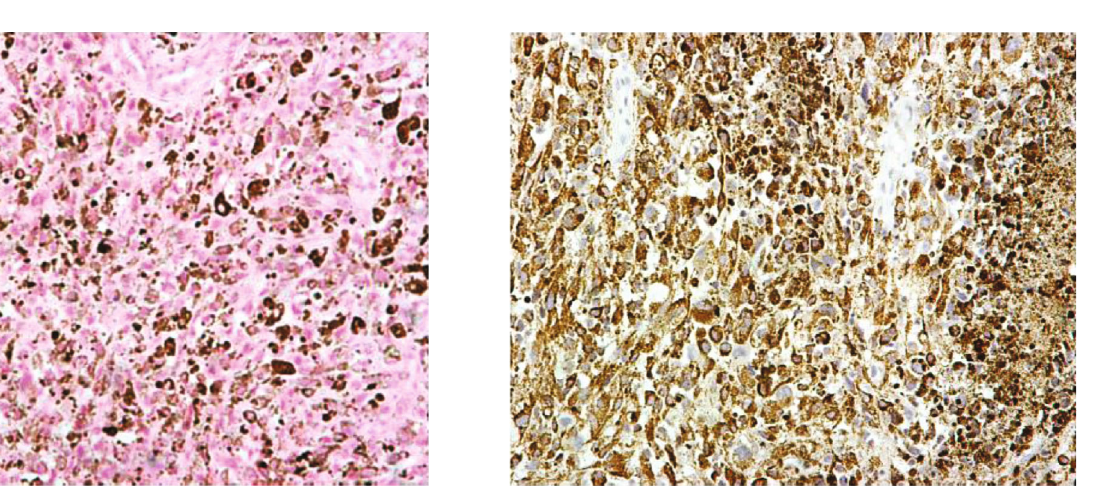
Figure 1: A fully pigmented growth was observable completely covering the entire external cervical os with smooth borders.